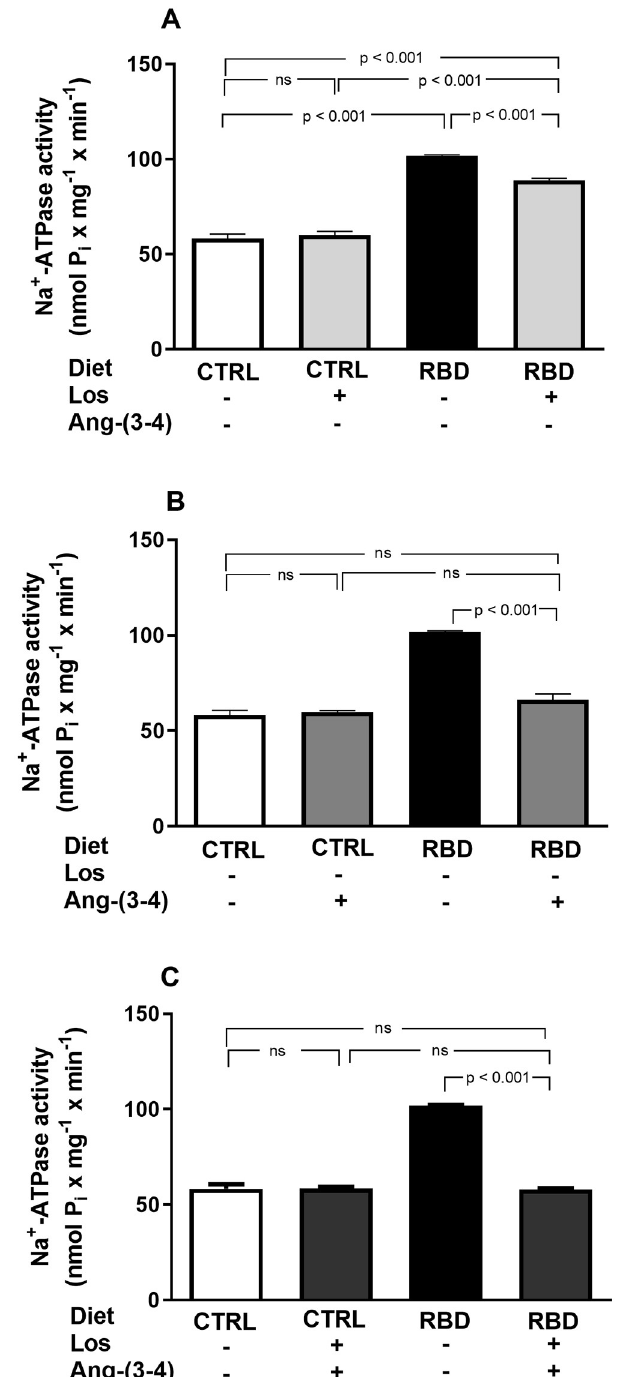
Fig 14. Upregulation of the ouabain-resistant Na + -ATPase from renal proximal tubule cells of chronically undernourished rats. Determinations were carried out in plasma membrane-enriched preparations isolated from the outermost region of the renal cortex ( cortex corticis ) on day 92. (A) Effects of Losartan. Comparison of Na + -ATPase activity of CTRL and RBD rats without chronic administration of Losartan, and effects of Losartan administration (30 mg/kg body mass per day, from 28 to 92 days of life) to CTRL and RBD rats, as indicated on the abscissa . (B) Responses to Ang-(3–4). Effects of oral administration of a single dose of Ang-(3–4) (80 mg/kg body mass) on Na + - ATPase activity of CTRL and RBD rats, as indicated on the abscissa . (C) Responses to Losartan+Ang-(3–4). Effects of combined administration of Losartan and Ang-(3–4) on Na + -ATPase activity of CTRL and RBD rats, as shown on